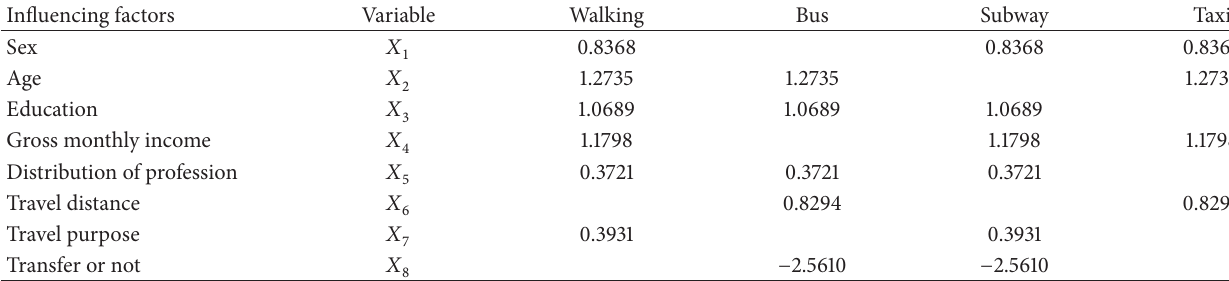
Table 3: The values of influencing